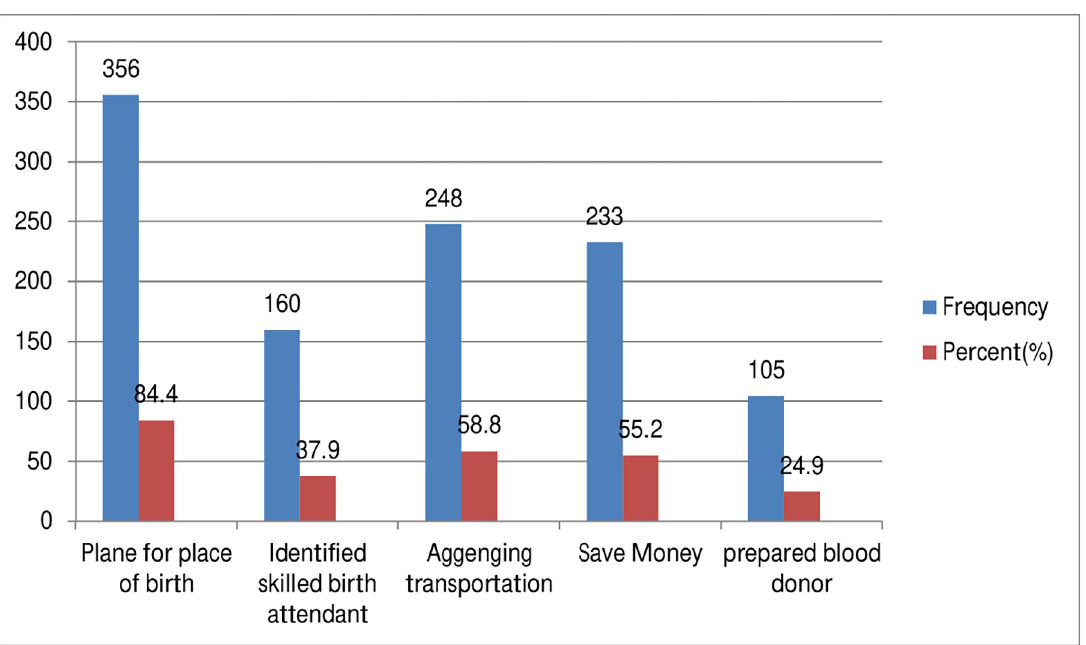
Fig 1. Components of Birth preparedness and complication readiness items in Yirgalem general Hospital, Sidama Zone, Ethiopia; 2019 (n = 422).